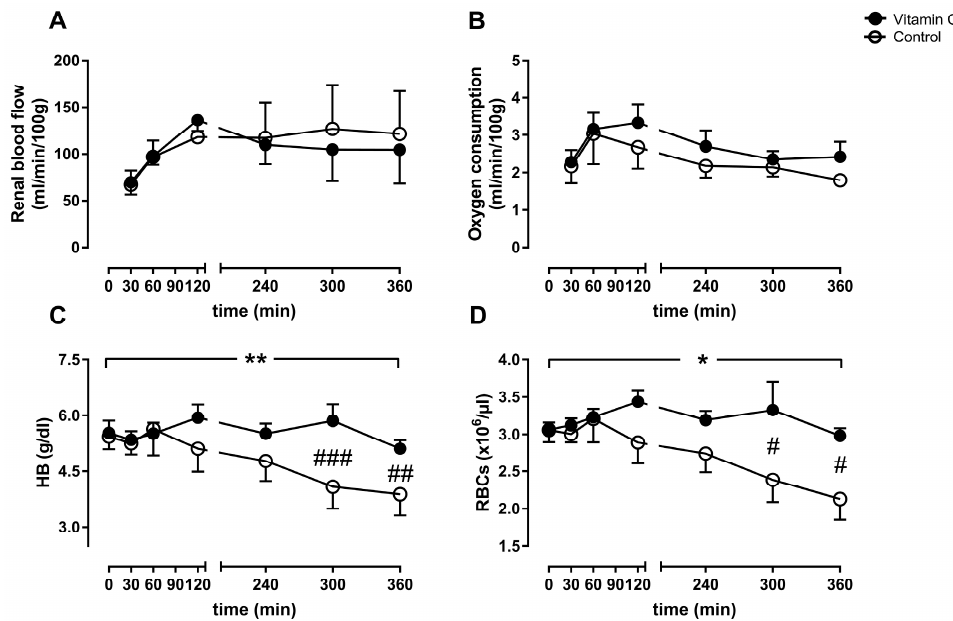
Figure 1. Perfusion parameters displayed as renal blood flow (A), oxygen consumption (B), arterial hemoglobin (HB, C), and the red blood cell count (RBCs, D). */** p < 0.05/0.01 effect of time for the control group; ### p < 0.001 vs. Control, ## p < 0.01 vs. Control, # p < 0.05 vs. Control.